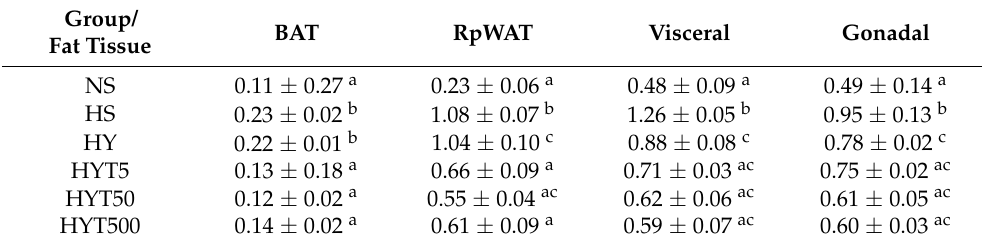
Table 1. Fat percentage (%) in male offspring on PND